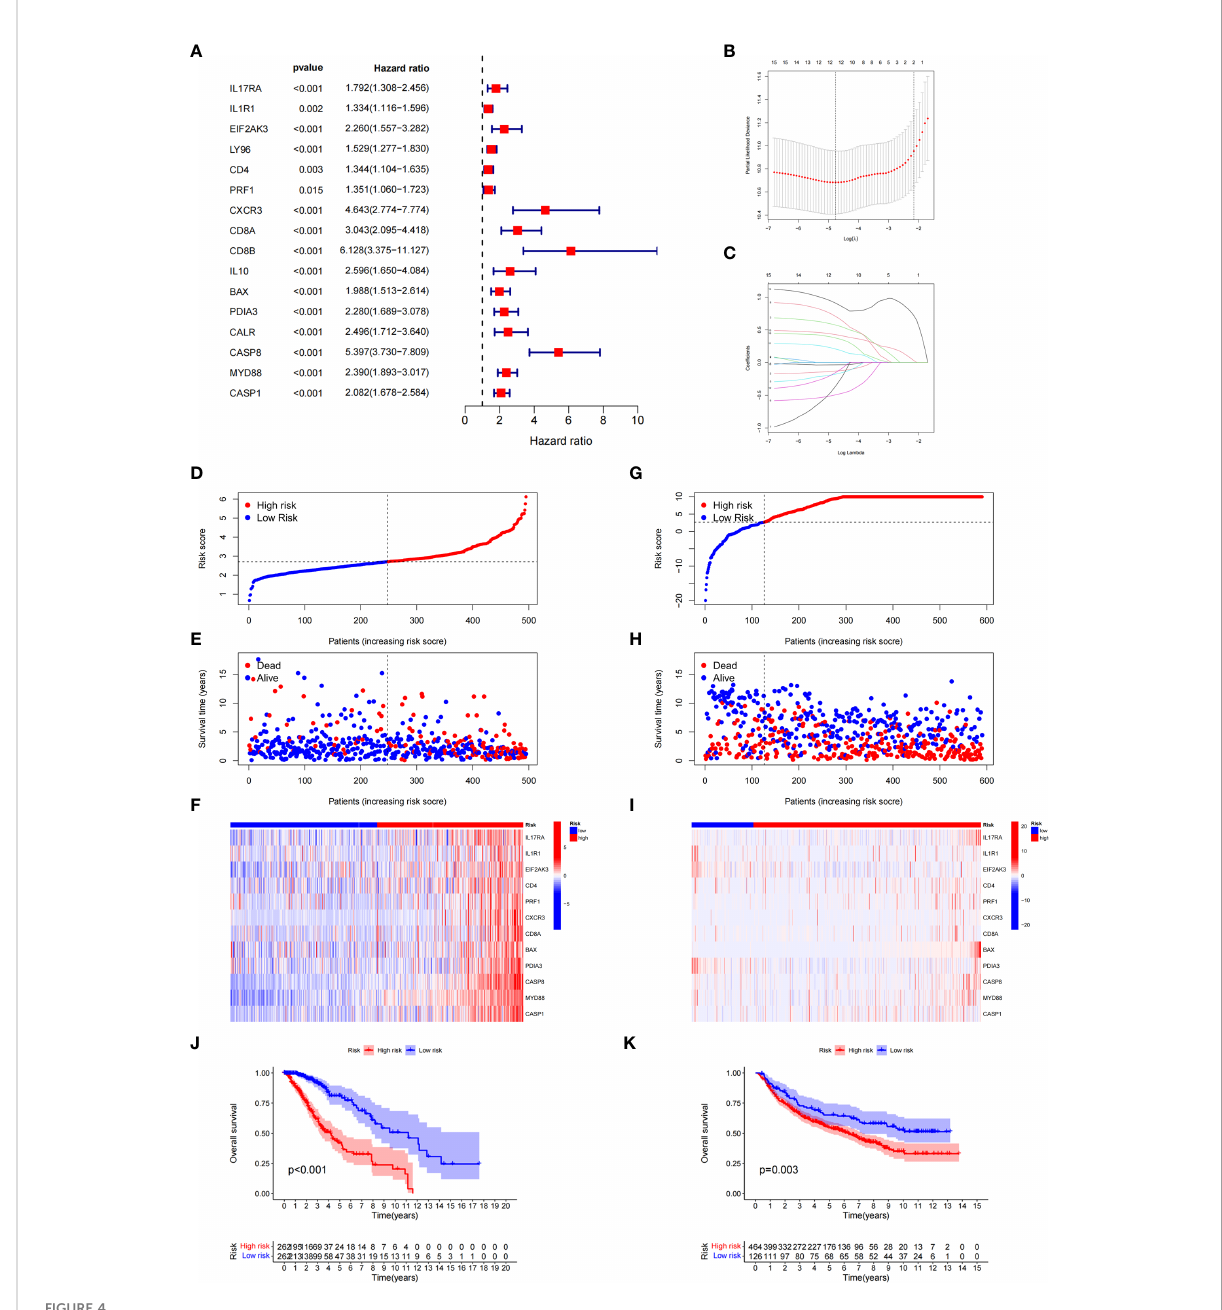
FIGURE 4 Construction and validation of the ICD-related risk signature. (A) Forest plot of overall survival (OS) analysis using univariate Cox analysis for evaluating the prognostic value of the ICD genes. (B, C) Lasso Cox analysis identi fi ed 16 ICD-related genes most associated with OS in the TCGA dataset. (D – F) Risk score distribution (D) , survival status of each patient (E) , and heatmaps of the prognostic 12-gene signature (F) in TCGA database. (G – I) Risk score distribution (G) , survival status of each patient (H) , and heatmaps of the prognostic 12-gene signature (I) in the CCGA database. (J, K) Kaplan – Meier analysis of the prognostic signi fi cance of the risk model in TCGA and CGGA